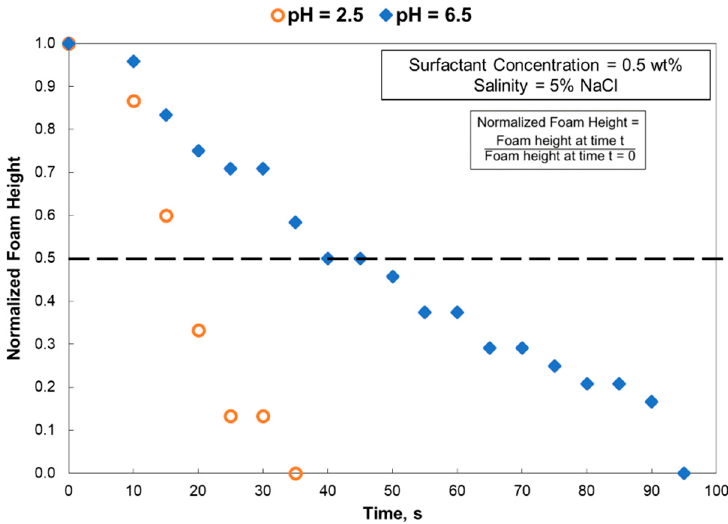
Figure 10. Effect of solution pH on the foam stability at 150 °F (65 °C) and 500 psi (34.5